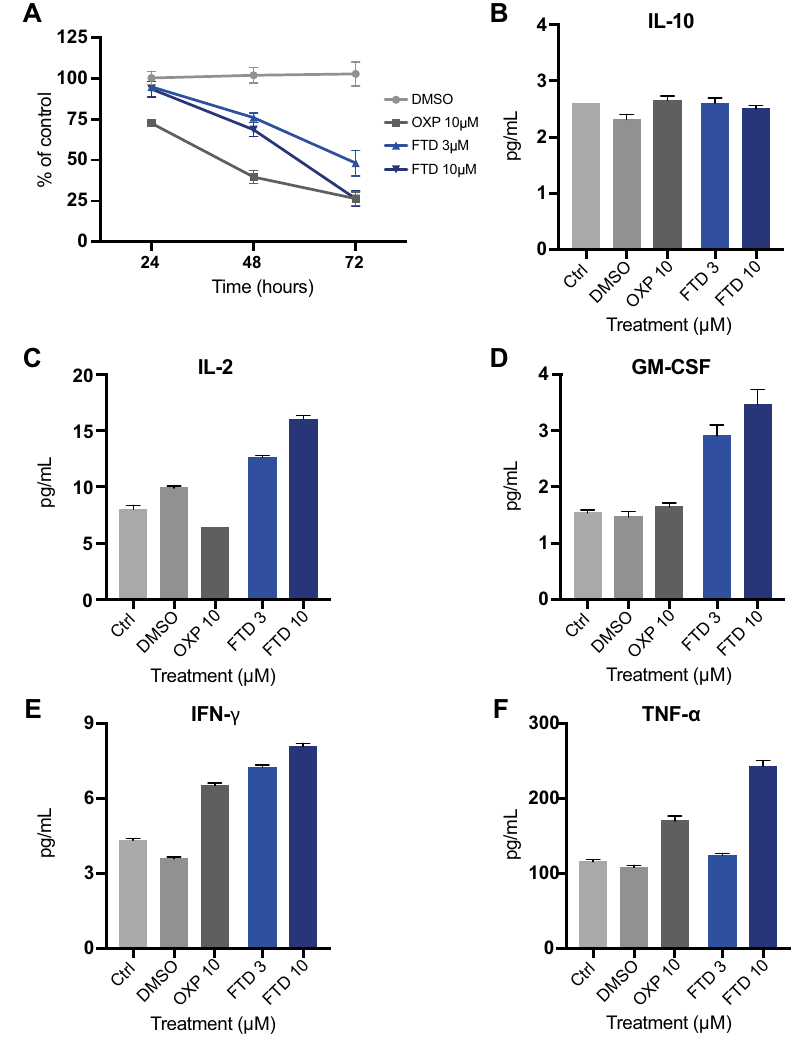
Figure 2. Trifluridine increases secretion of pro-inflammatory cytokines. ( A ) Viability measured over time by GFP expression in HCT116-GFP co-culture with human PBMCs, treated with DMSO vehicle, OXP, or FTD (n = 9). Cytokines ( B ) IL-10, ( C ) IL-2, ( D ) GM-CSF, ( E ) IFN-γ, and ( F ) TNF-α measured in supernatants of HCT116-GFP co-cultured with human PBMCs and treated for 48 h using a Luminex MAGPIX